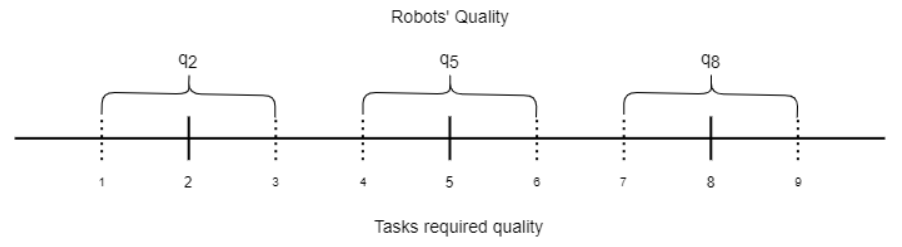
Figure 1. Ideal tasks assignment based on